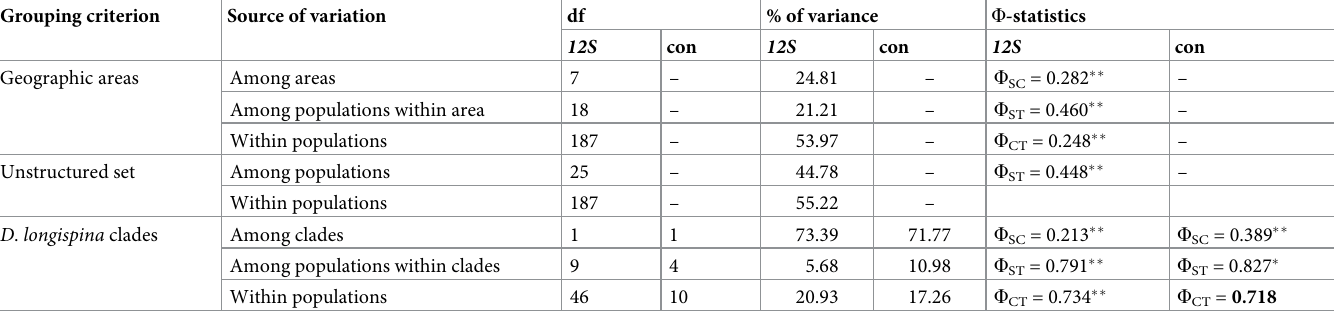
Table 2. Analysis of molecular variance AMOVA for the extended 12S and concatenated 12S + 16S + ND2 datasets of the mtDNA for D . longispina and two clades. The significances of F -statistics values were tested by a permutation test with 10 000 replicates. Grouping